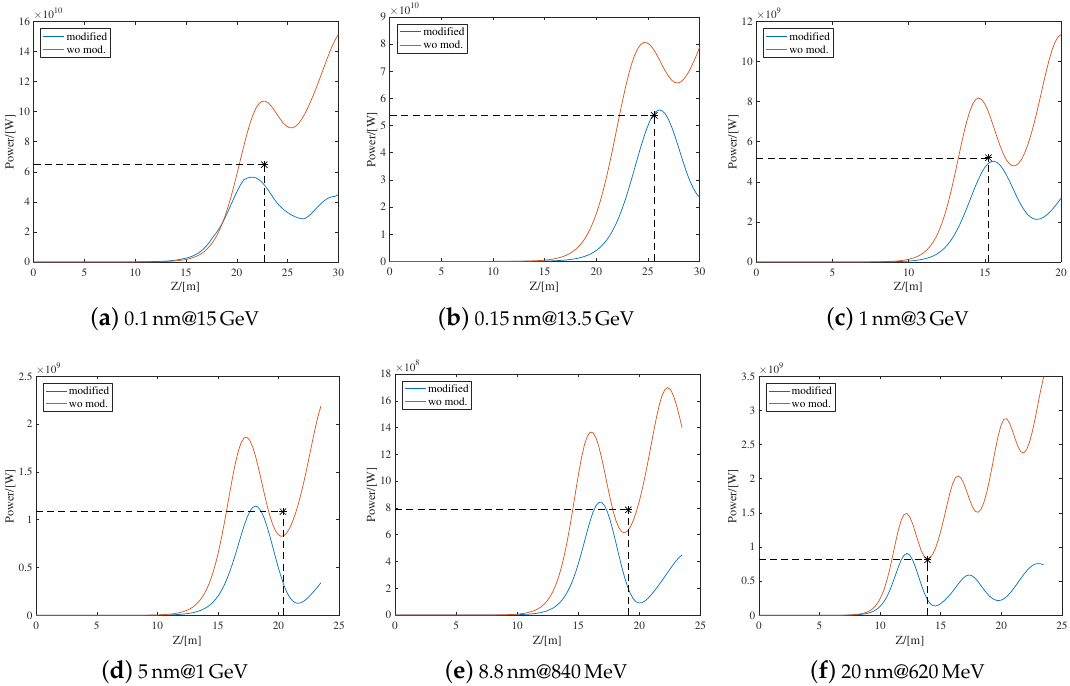
Figure 1. The free-electron laser (FEL) power gain curves under different conditions. From ( a – f ), the electron beam energies are 15GeV, 13.5GeV, 3GeV, 1GeV, 840MeV, 620MeV and the corresponding FEL wavelengths are 0.1nm, 0.15nm, 1nm, 5nm, 8.8nm, and 20nm, respectively. In this figure, the blue lines and red lines represent the FEL power with and without diffraction modifications, respectively. The black stars indicate the saturation points that are calculated by Xie’s formulas [29]. The errors of saturation power and saturation length are approximately 10%, showing significant improvements as compared to those without diffraction